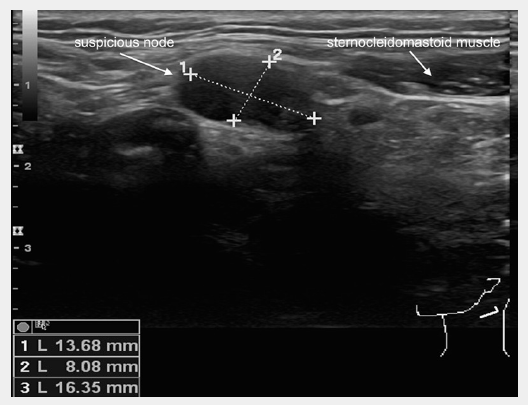
Sonographic appearance of a suspicious lymph node on palpation in level II left from a patient with a small squamous cell carcinoma of the right lateral tongue. The absence of an echogenic hilus, the size of more than 1.5cm and the shape of the lymph node renders it sonographically suspicious. The cytology result after ultrasound- guided fine needle aspiration confirms the presence of a contralateral positive